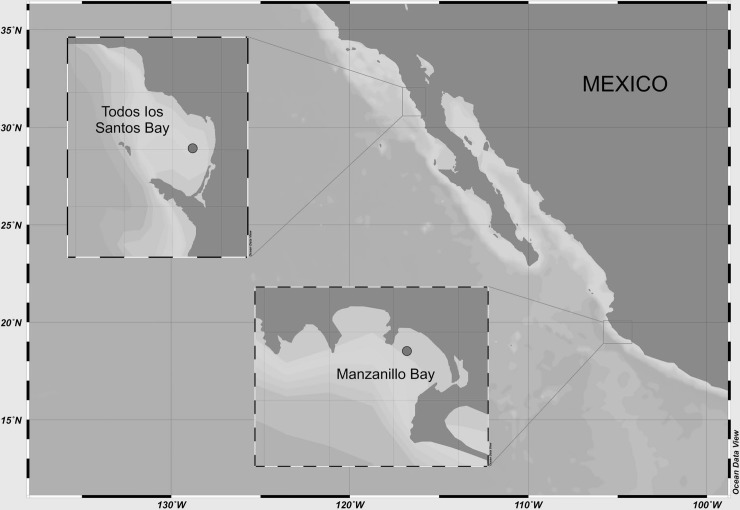
Map of the Mexican Pacific coast showing Todos Santos and Manzanillo Bays.